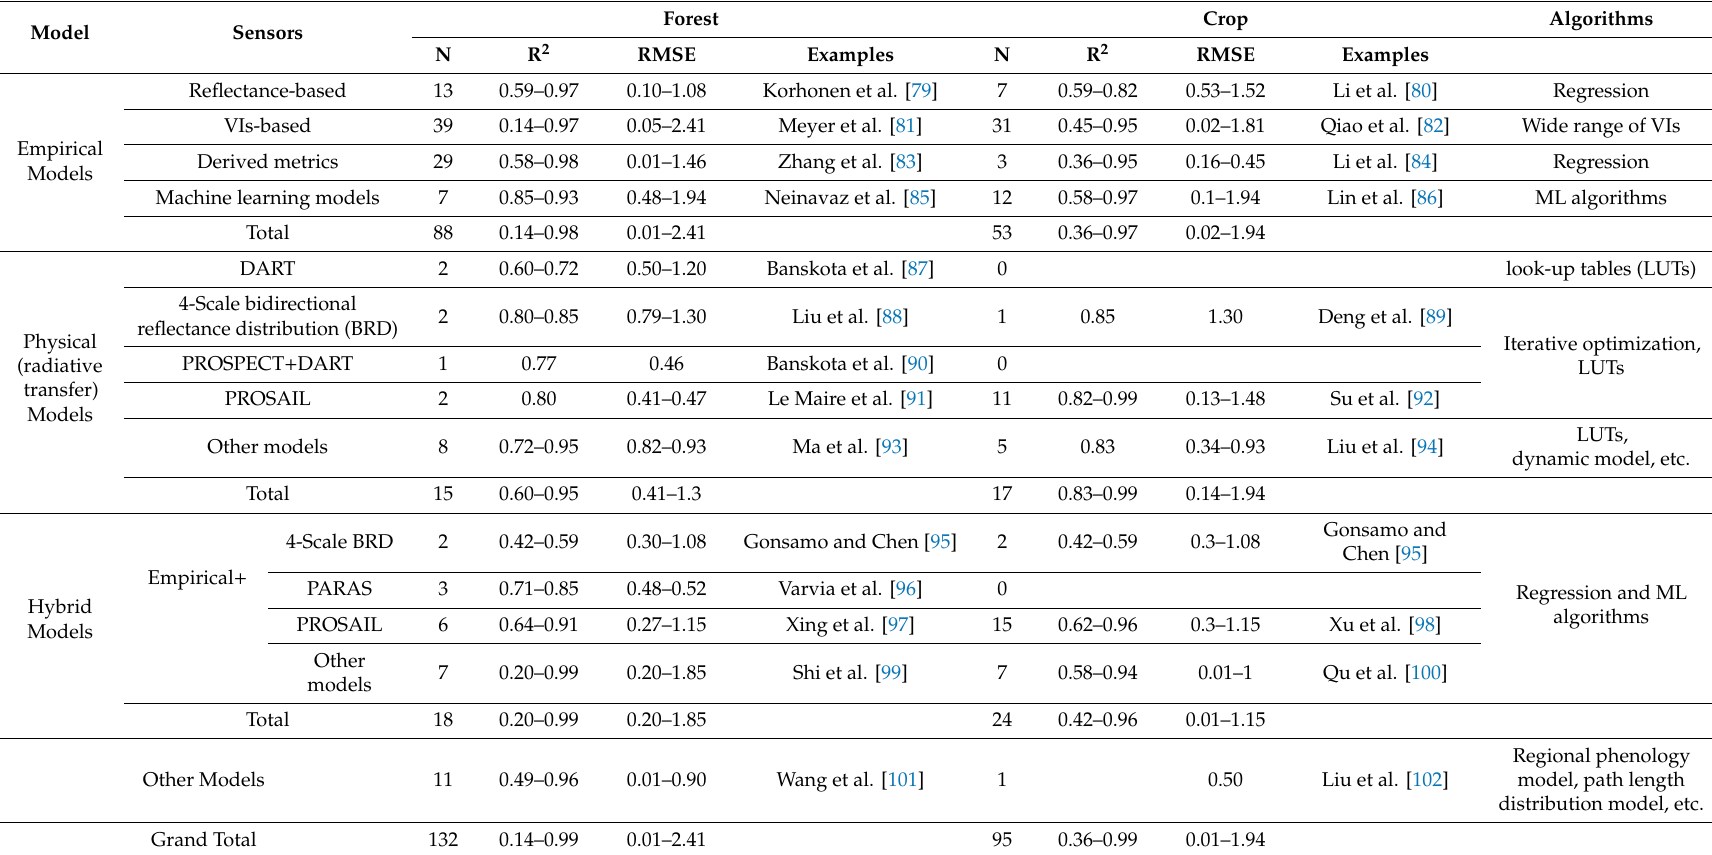
Table 3. Summary of models and model performance for forest and crop LAI estimation reported from